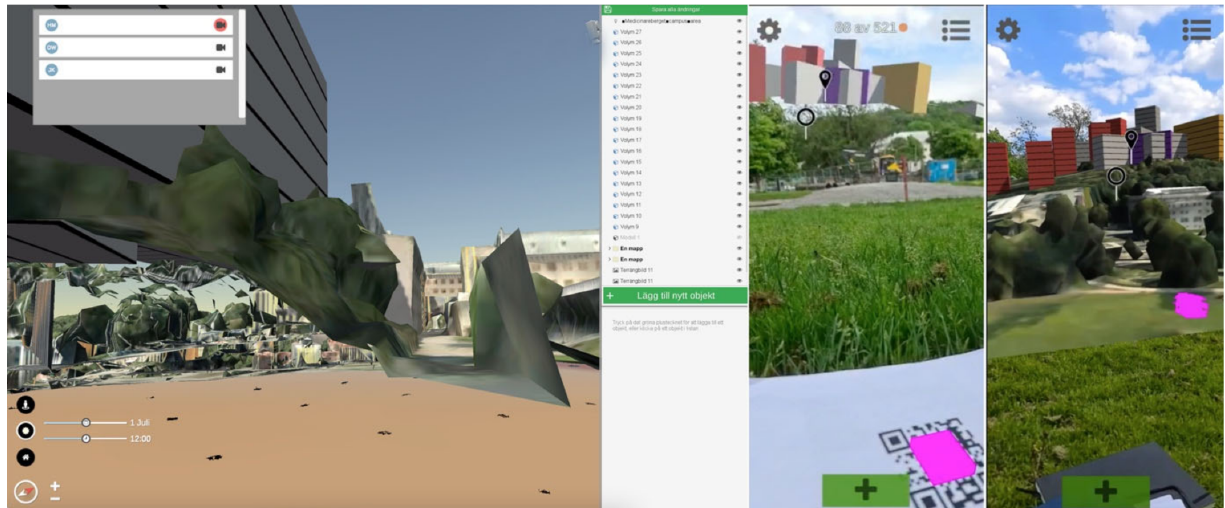
Figure 13. Problematic issues with the 3D mesh model. The vegetation is broken into polygons in close-up detail, and the building volumes are placed on top of the vegetation. The image to the left shows the web-based desktop station, the image in the middle MAR illustrations occlusion issues when the background 3D model is hidden, and the image to the right shows when the background mesh model is projected on-site. The roughness of the vegetation in the model is problematic when zoomed in. Likewise, the projection on MAR shows rough occluded cuts at the bottom (Image in the